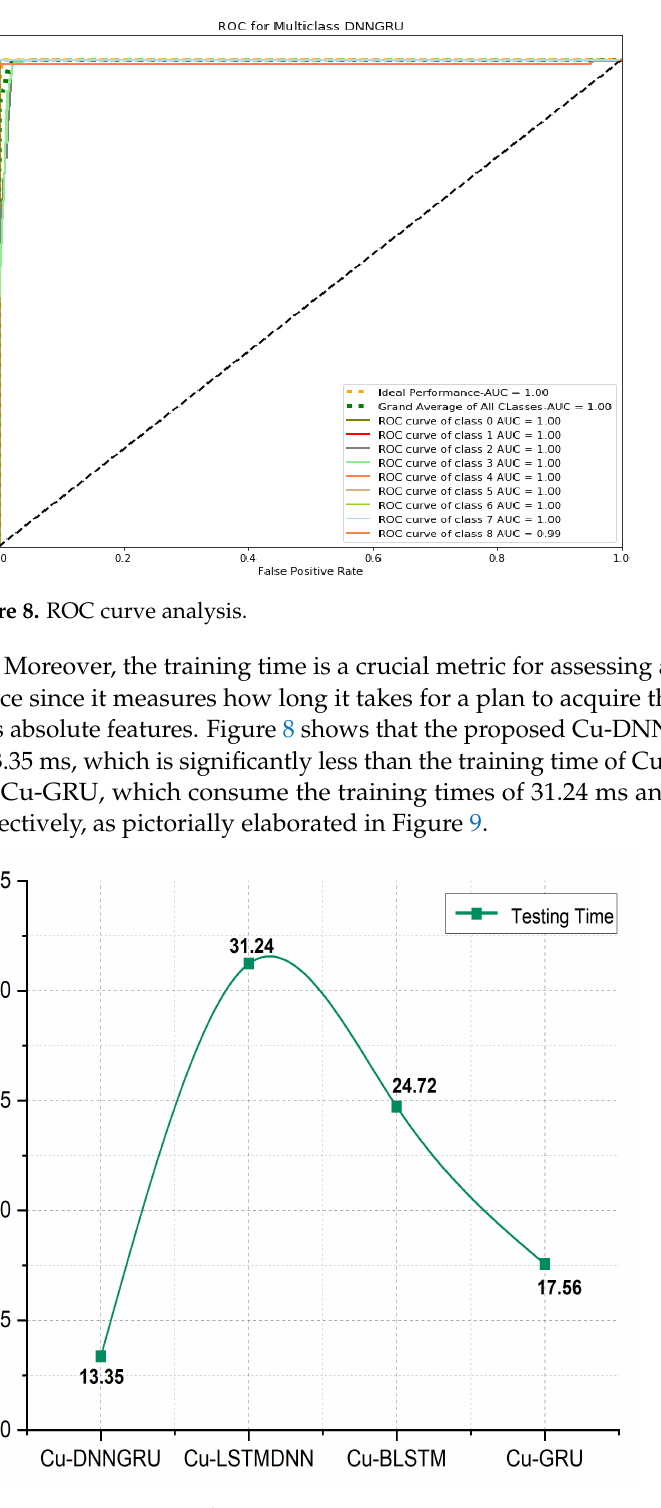
Figure 9. Testing time